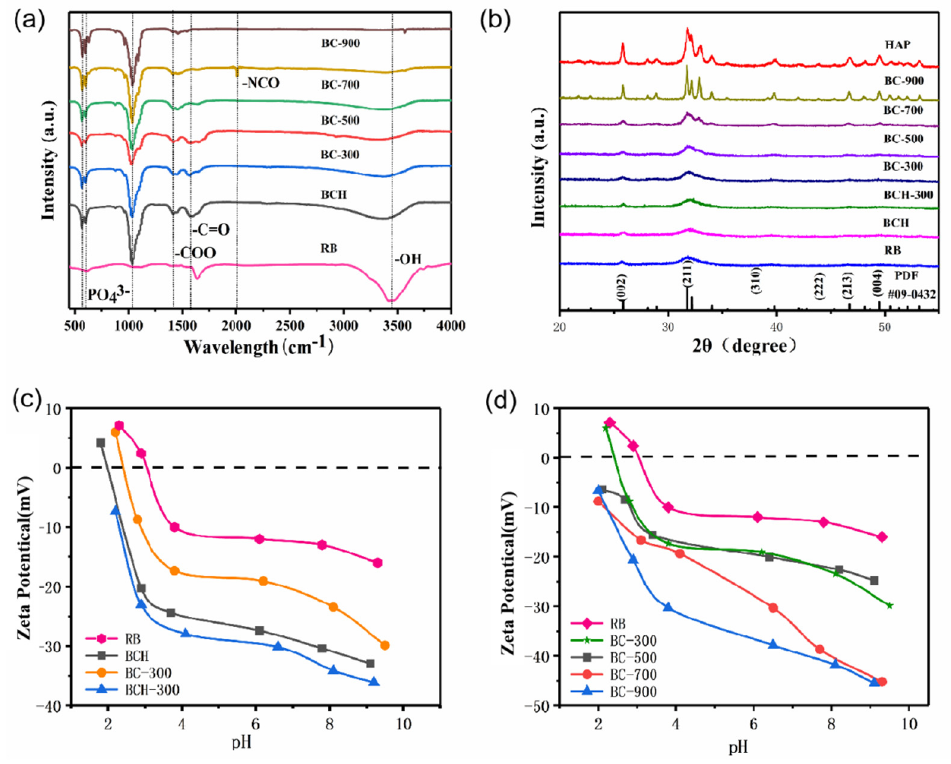
Figure 2. ( a ) Fourier-transform infrared spectra, ( b ) XRD patterns, and ( c , d ) the zeta potential of BC and BCH samples.